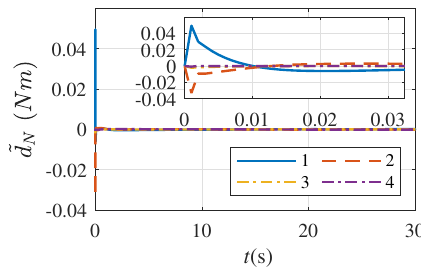
Figure 8. Estimation error.